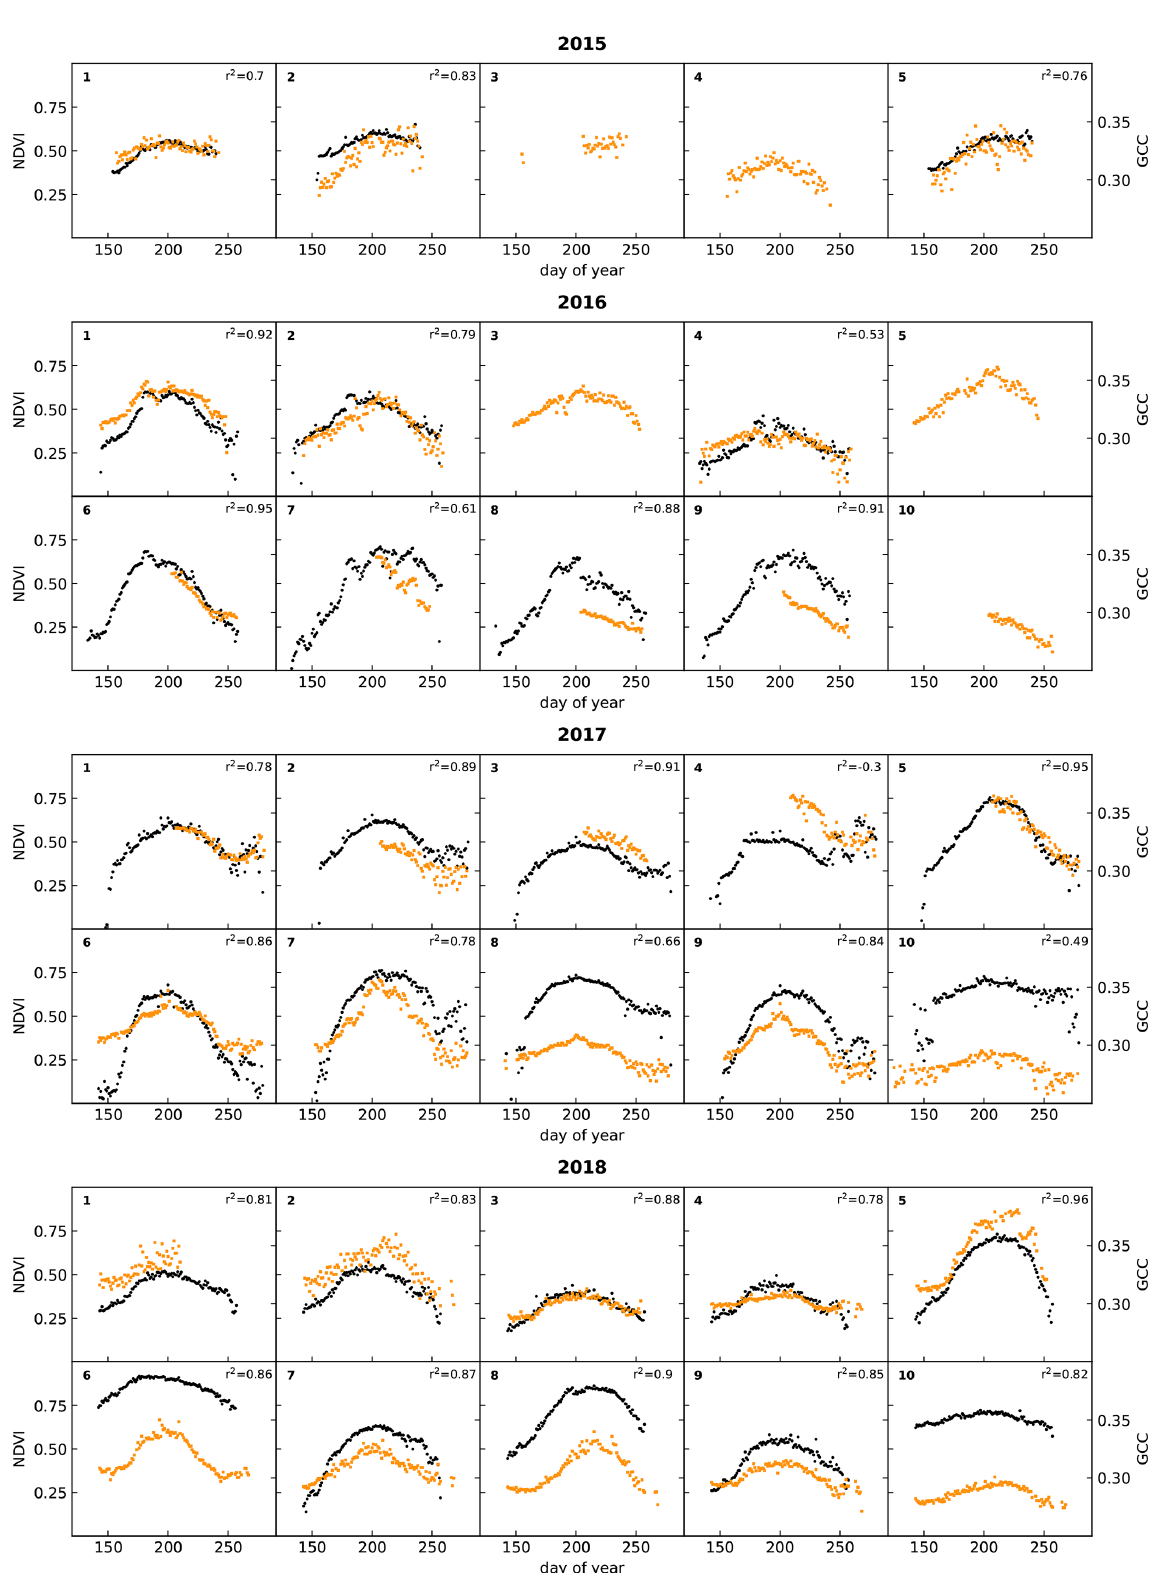
Figure 5. Time series of daily medians of NDVI (black) and GCC (orange) for all racks (labelled in the top left corner of each subplot). Correlations between NDVI and GCC are also indicated. See Table 3 for details on the type of RGB camera used.